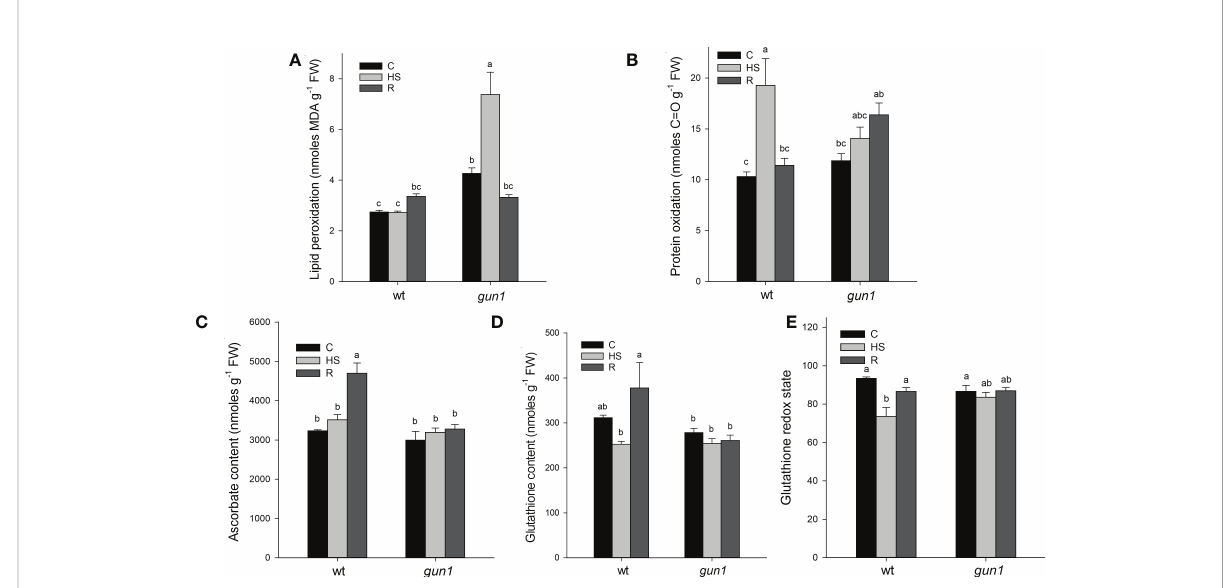
FIGURE 5 Oxidative markers and non-enzymatic antioxidants of Arabidopsis wild type (wt) and gun1 plantlets, grown at control temperature (C) or subjected to Heat Stress (HS; 2 hours at 45°C), followed by short recovery (R; 3 hours at 22°C). (A) Lipid peroxidation, measured as malondialdehyde content and (B) protein oxidation measured as total protein carbonyl groups. (C) Total ascorbate and (D) glutathione contents. (E) Glutathione redox state calculated as percentage of the ratio between reduced and total glutathione. The values are the means ± standard errors of fi ve independent experiments. Different letters indicate signi fi cant differences obtained by one-way ANOVA test (P<